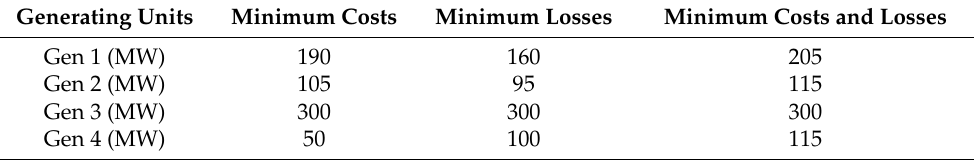
Table 8. Optimal solar PV power considering different objective functions for Nigeria system.